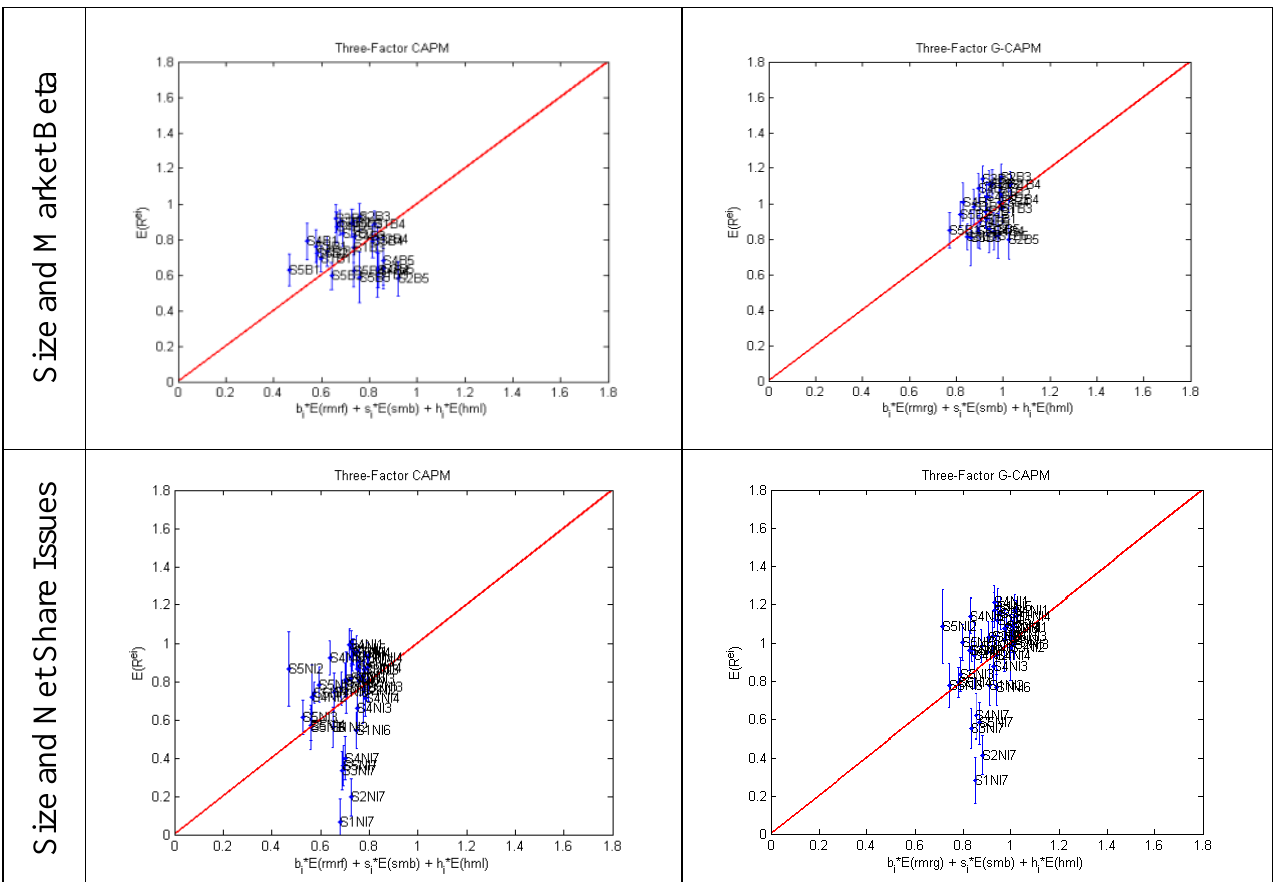
Figure 3. Comparison of traditional and zero-beta three-factor models. We are grateful to Cochrane (2014) for providing the Matlab codes.